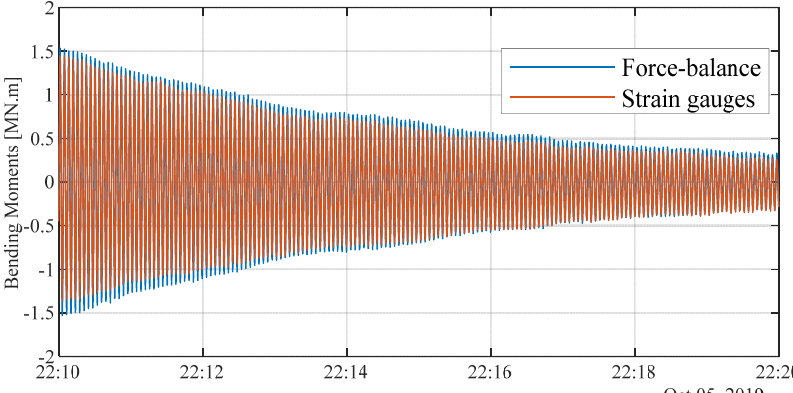
Figure 9. Bending moment variations at the base of the tower estimated from acceleration and strain time series during a rotor stop event.